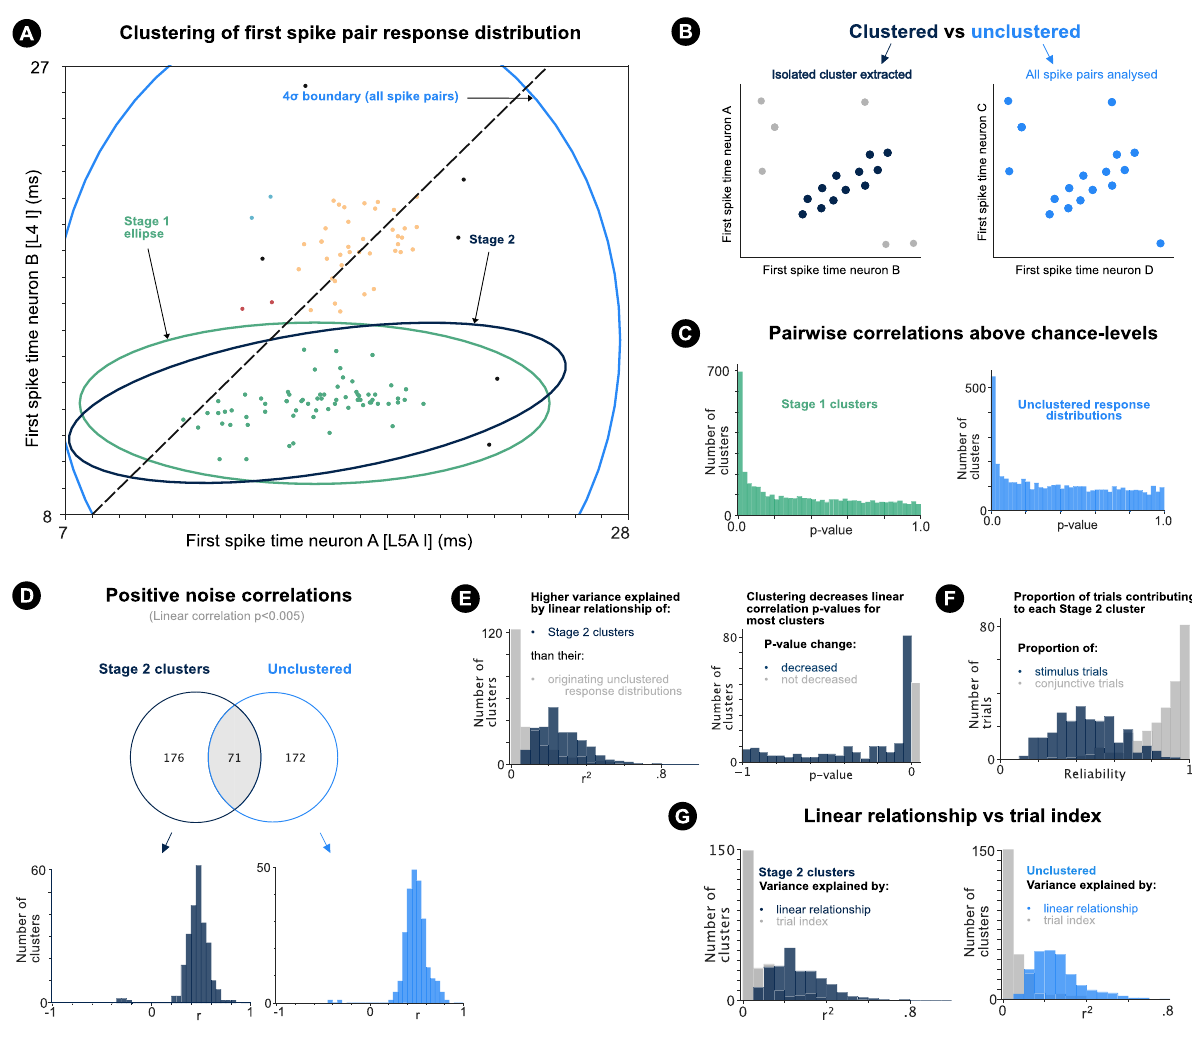
Figure 3. Correlated clusters and correlated unclustered response distributions. ( a ) First spike response distribution for two neurons (L5AI, L4I) over 50ms following cortical onset (1 outlier out of view). Point colours illustrate DBSCAN clustering (epsilon = 1.35; Methods). Green flat ellipse illustrates 4 σ confidence interval of Stage 1 cluster. Dark blue angled ellipse illustrates 4 σ confidence interval of Stage 2 cluster. Light blue ellipse illustrates 4 σ ellipse of all spike pairs under independence and normality assumption. ( b ) Illustration of detected cluster in first spike pair response distribution (left) and unclustered first spike pair response distribution (right). ( c ) Linear regression p -values for Stage 1 clusters (left) and unclustered response distributions (right). ( d ) Top: number of correlations ( p < 0.005 ) detected for the clustered (Stage 2 clusters) and unclustered case. Intersection shows the number of response distributions from which a correlation was detected by the clustering algorithm and for the unclustered case. Bottom: linear regression r-values of correlated ( p < 0.005 ) Stage 2 clusters (left) and unclustered response distributions (right). ( e ) Left: histogram of variance explained ( r 2 ) by the spike time linear relationship of each Stage 2 cluster (dark blue) and the linear relationship of the unclustered response distributions from which Stage 2 clusters were extracted (grey). Right: histogram of change in linear regression p -values introduced by clustering for response distributions from which Stage 2 clusters were extracted. Particularly, histogram shows Stage 2 cluster linear regression p -values minus originating response distribution linear regression p -values. Clustering reduces p -values in most cases (dark blue). ( f ) Histogram showing for each Stage 2 cluster, the proportion of conjunctive (both neurons spike) trials contributing a sample to the cluster (grey) and the proportion of stimulus trials contributing a sample to the cluster (dark blue). ( g ) Histogram of r 2 -values of linear multi-output spike pair prediction from trial index (grey) and linear correlation (dark blue, blue) for Stage 2 cluster spike times (left) and unclustered response distributions